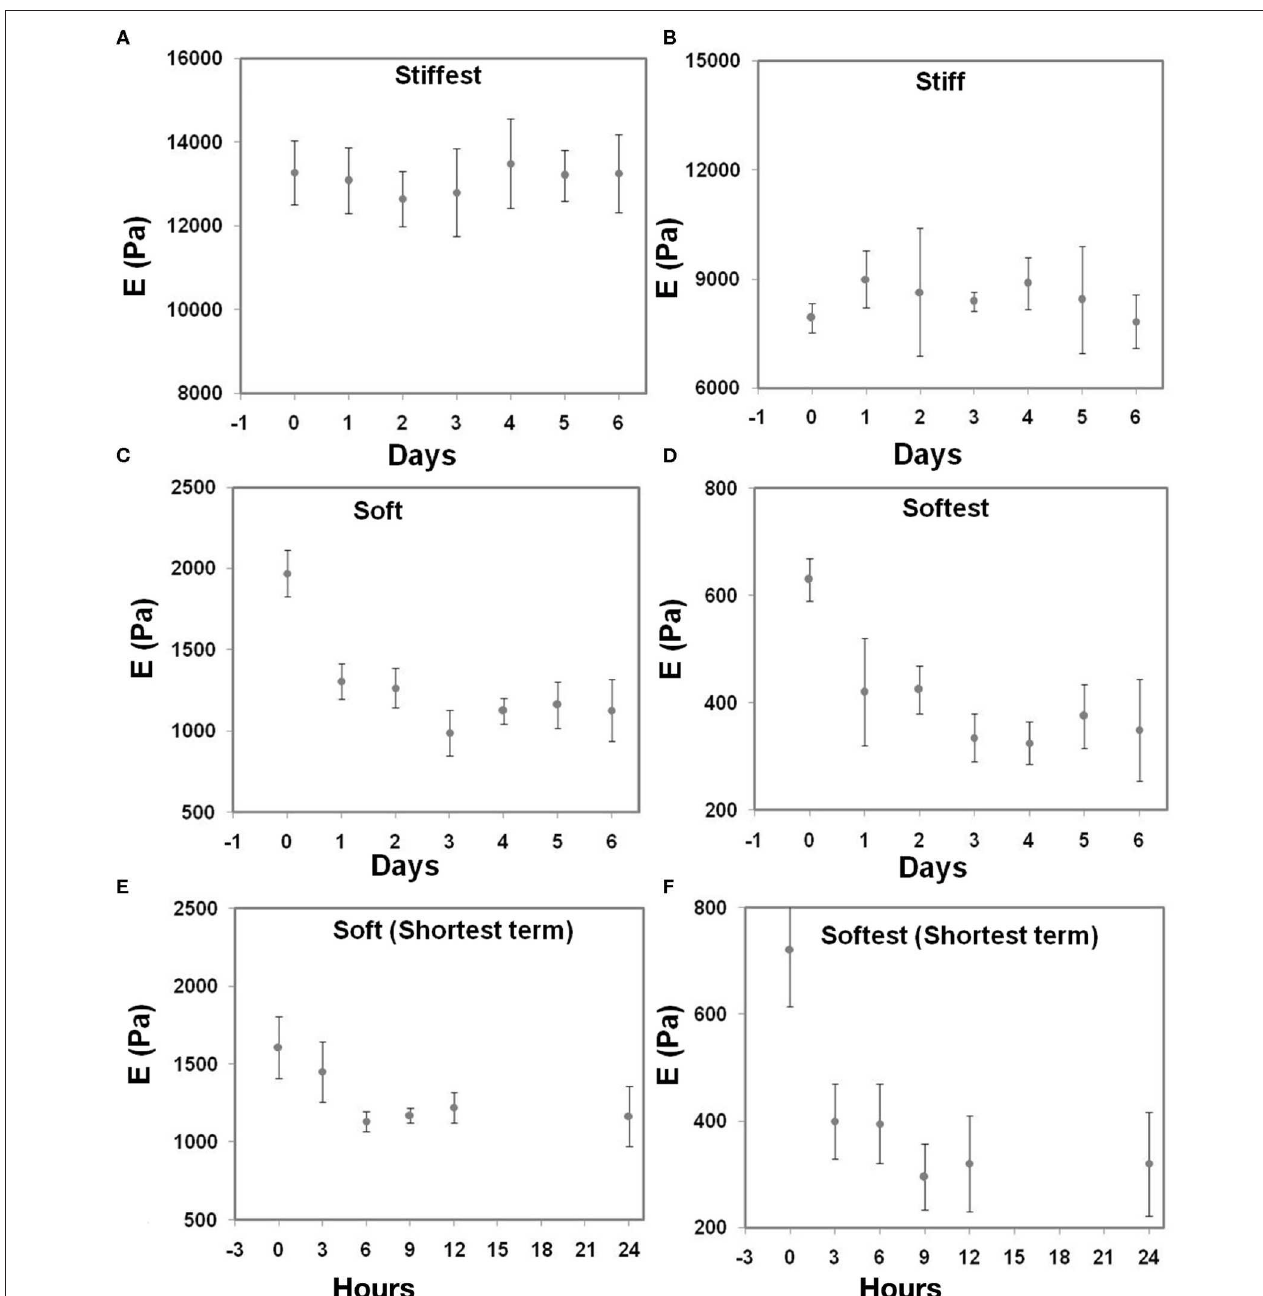
FIGURE 3 | Local elastic modulus (as determined by AFM) of substrate-attached gels as a function of swelling time for four different hydrogel compositions during long term swelling up to 6 days (A,B) stiffest and stiff; (C,D) soft and softest; (E,F) are the short term swelling times from 0 to 24h. All measurements were done in triplicate (whiskers indicate